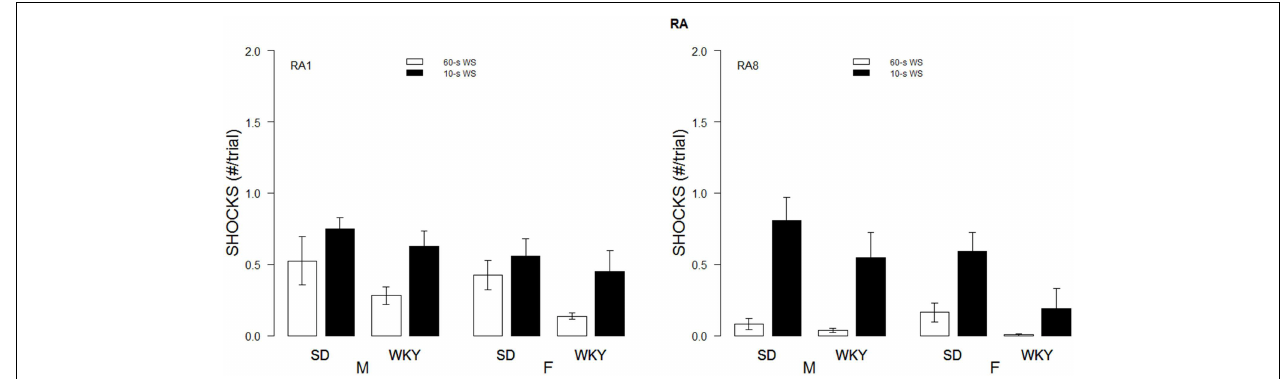
FIGURE 5 | Shock received during re-acquisition. Shocks rates per trial are depicted for the first session (RA1, left panel) and 8th session of re-acquisition (RA8; right panel) as a function of strain, sex, and WS duration. Initial male WKY rats experienced less shocks. Cross over from 60 to 10s led